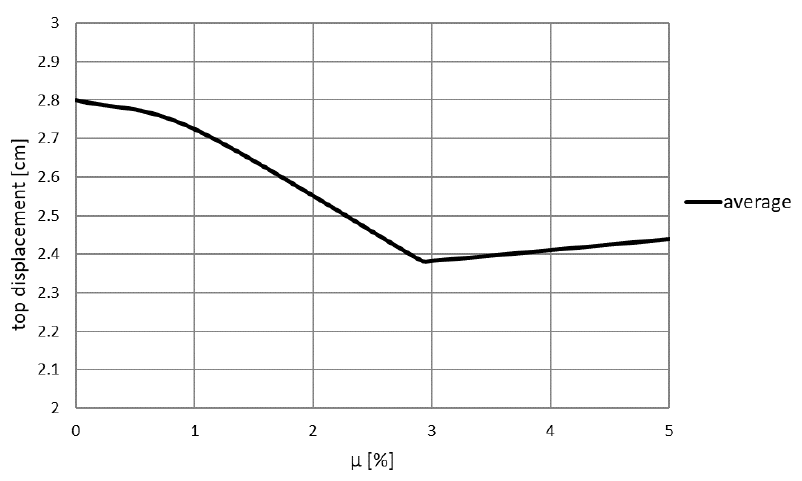
Figure 10. Top displacement against the mass ratio, μ considering the TMD positioned at 26.50 m.